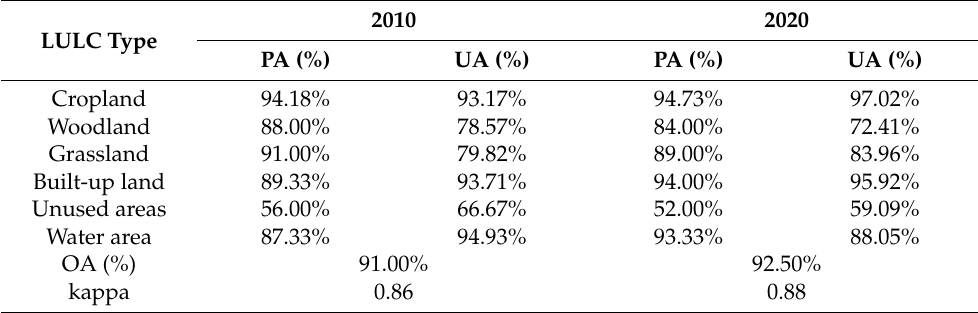
Table 4. Classification accuracy of